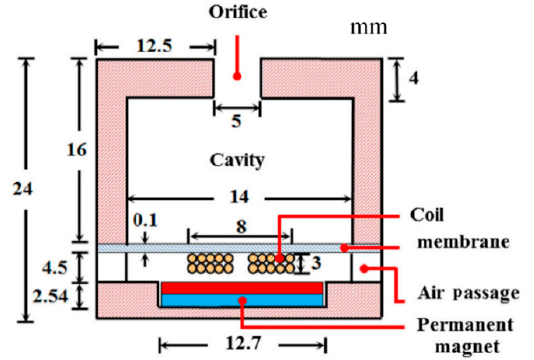
Figure 7. Schematic diagram of the electromagnetism-based AEH device; a coil is placed at the resonator’s bottom and a permanent magnet is placed inside a holder. Reproduced with permission from [38]; published by Springer, 2016.